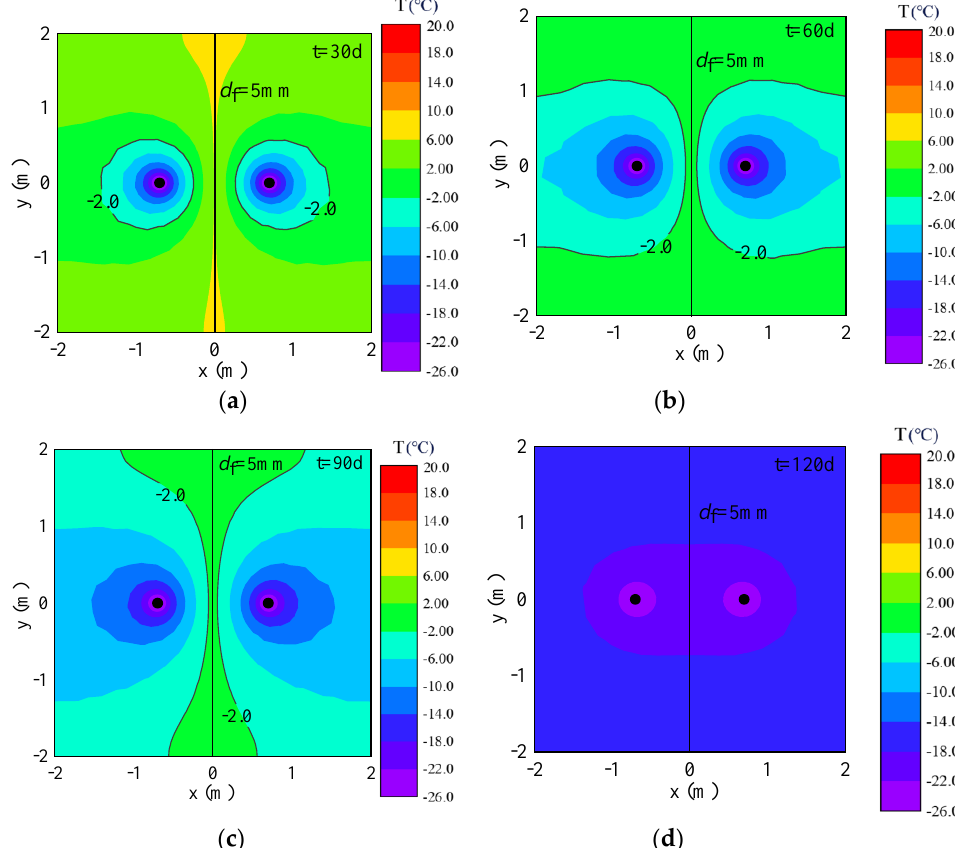
Figure 9. Interfacial temperature distributions of fractured rock mass during freezing with ground- water seepage velocity of 0.1 m/d: ( a ) t = 30 d; ( b ) t = 60 d; ( c ) t = 90 d; ( d ) t = 120 d.